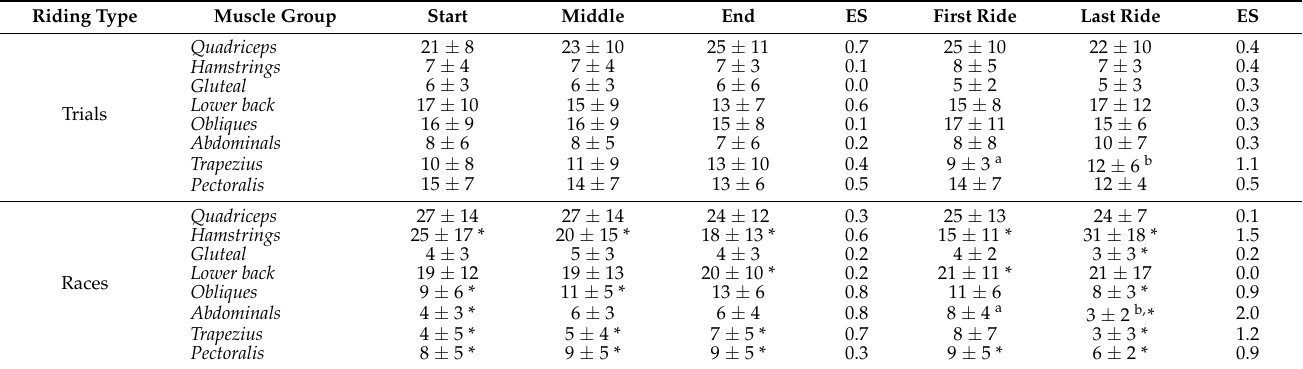
Table 6. Mean ( ± SD) muscle activity (%) of jockeys within a ride ( n = 48 trials, n = 16 races) and between the first and last ride during trials ( n = 48) and races ( n = 16). Effect sizes are between the first and last sectional of the